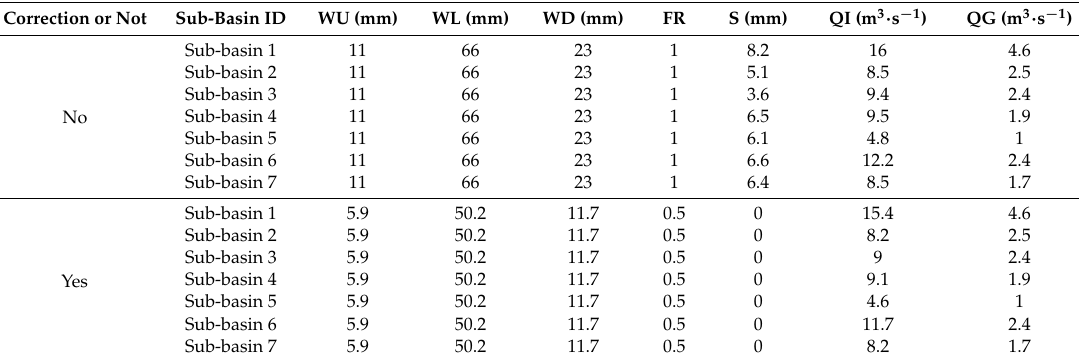
Table 22. The initial state variables of the flood 1983071303 in Zhonggeng Basin.